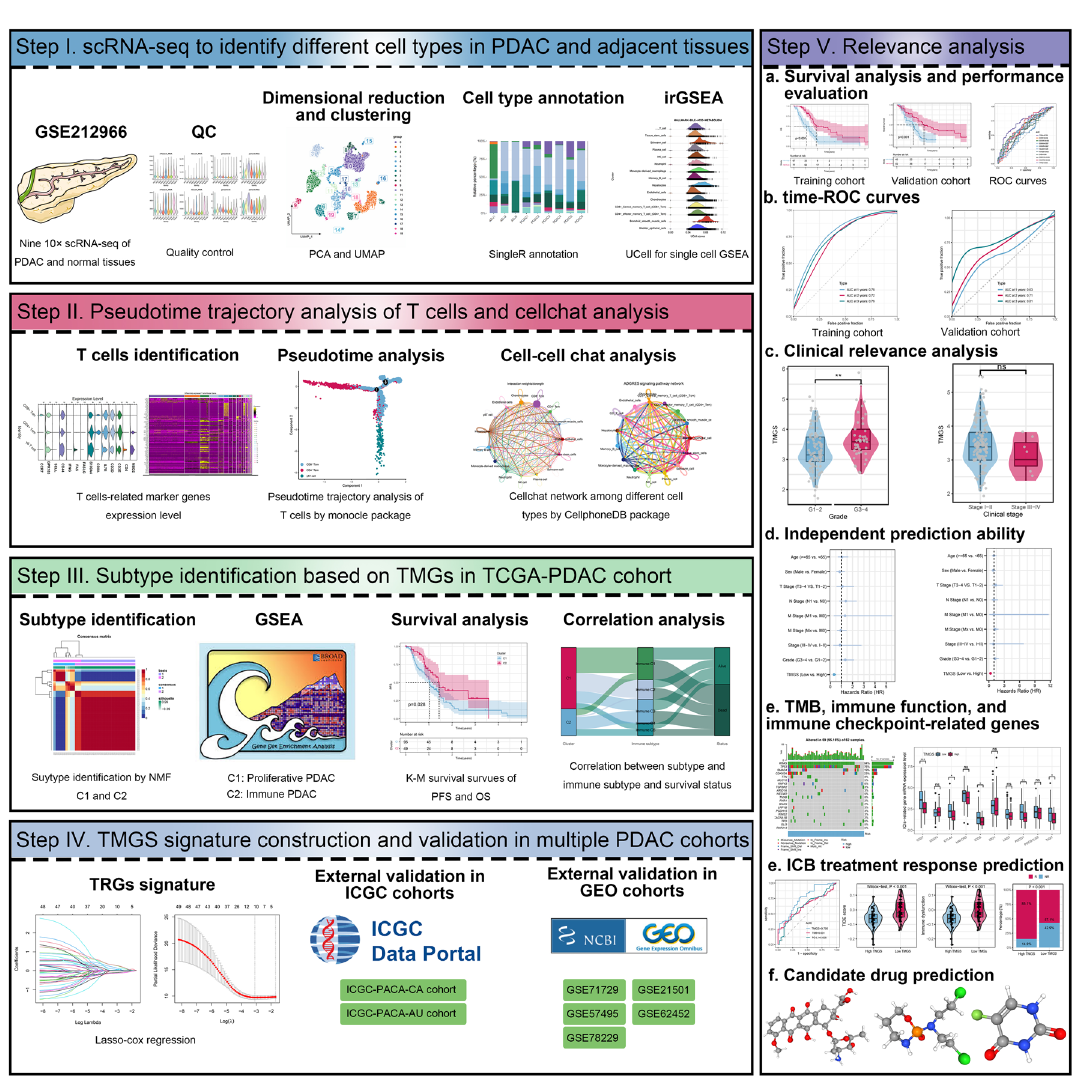
Figure 1. Workflow of the study. scRNA- seq , single-cell RNA sequencing; PDAC, pancreatic ductal adenocarcinoma; QC, quality control; GSEA, gene set enrichment analysis; TMGs, T cell marker genes;